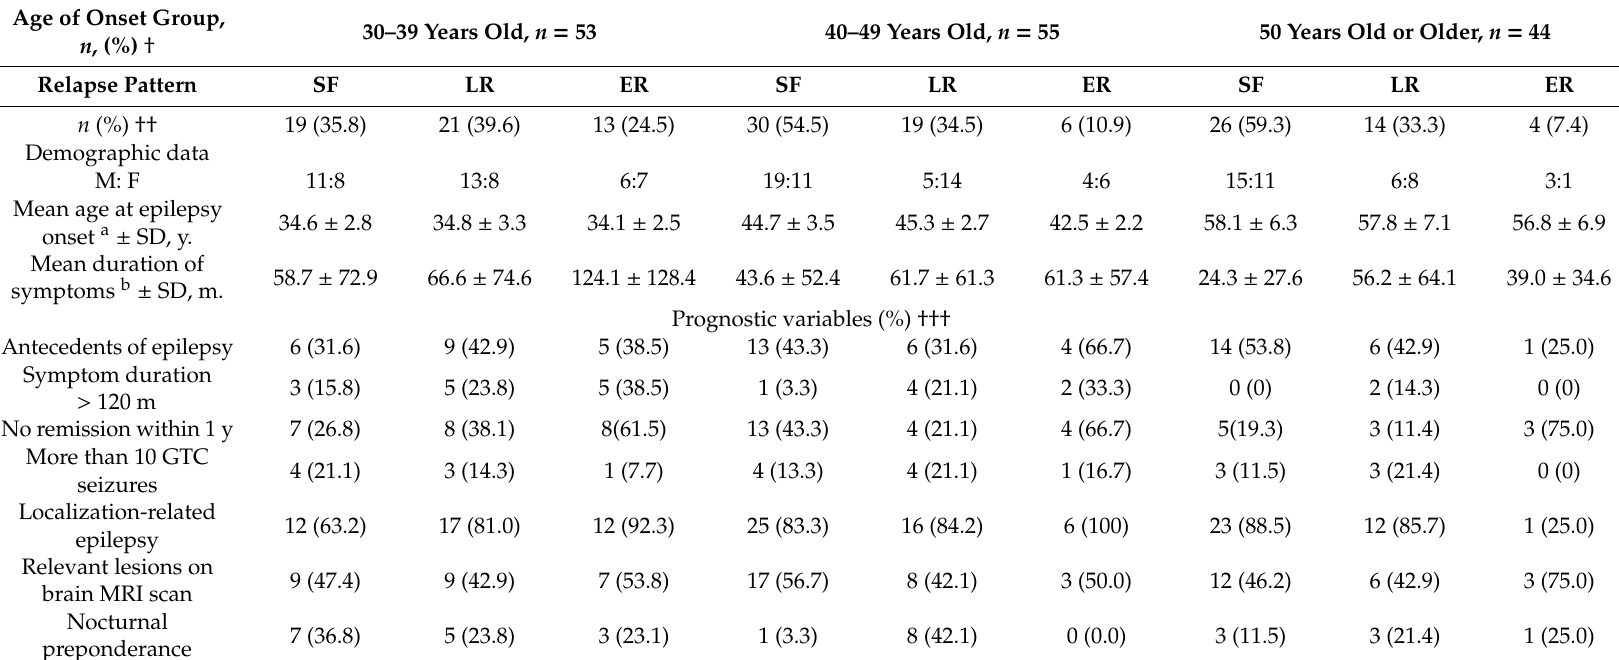
Table 2. Demographic data and prognostic variables according to relapse pattern in groups stratified by age of